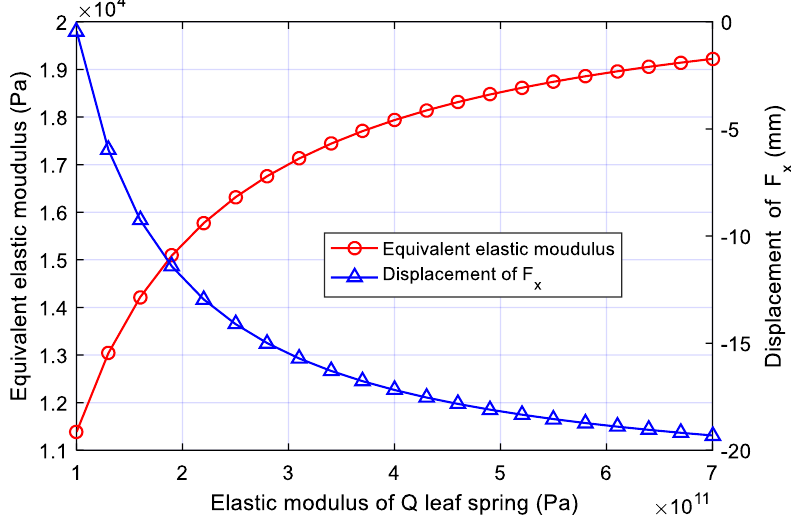
Figure 5. Variation of equivalent elastic modulus and displacement in the x -direction of the bionic leg with Eq, Ep = 197 GPa, initial length 800.9 mm, and compressive force 300 N. In order to verify the universality of the above laws, the variation trend of equivalent elastic modulus 𝐸̅ with Ep under different Eq is investigated. As shown in Figure 6, the blue curves represent the value of 𝐹 𝑥 and red curves represent the 𝐸̅ of the single leg. Among the curves with the same colors (red or blue), the lighter colors represent smaller Eq, and the curves with darker colors correspond to the values on the condition of larger Eq. The results show that the value of 𝐸̅ increases with Eq under the same Ep condition, and so does the increment rate. With the increase in the value of Eq, the displacement of the F point in the x -direction, F 𝑥 , increases, and the rate increases too. The laws presented above are the same as the ones illustrated in Figure 5, indicating that the variation trend is universal. As can be seen from Figure 6, with appropriate values of Ep and Eq, the horizontal displacement in the x -direction can turn to 0, but this does not mean that the horizontal displacement of the F point of the bionic leg in Figure 2 can remain unchanged in the whole process of locomotion, because the other two influencing factors, namely the initial length and load, will also lead to the change in the displacement of the F point in the x - direction. Therefore the absolute zero horizontal displacement in the process will not be realized, while a deformation range that approximates zero can be selected.